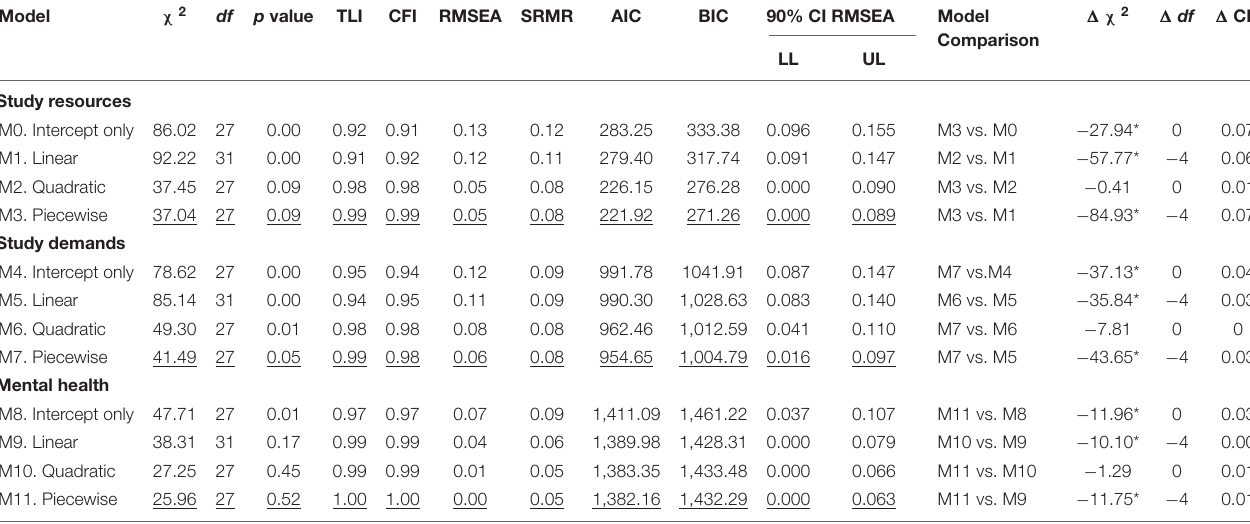
TABLE 4 | Unconditional latent growth model fit statistics, unstandardized means, and variances. Model χ 2 90% CI RMSEA Model